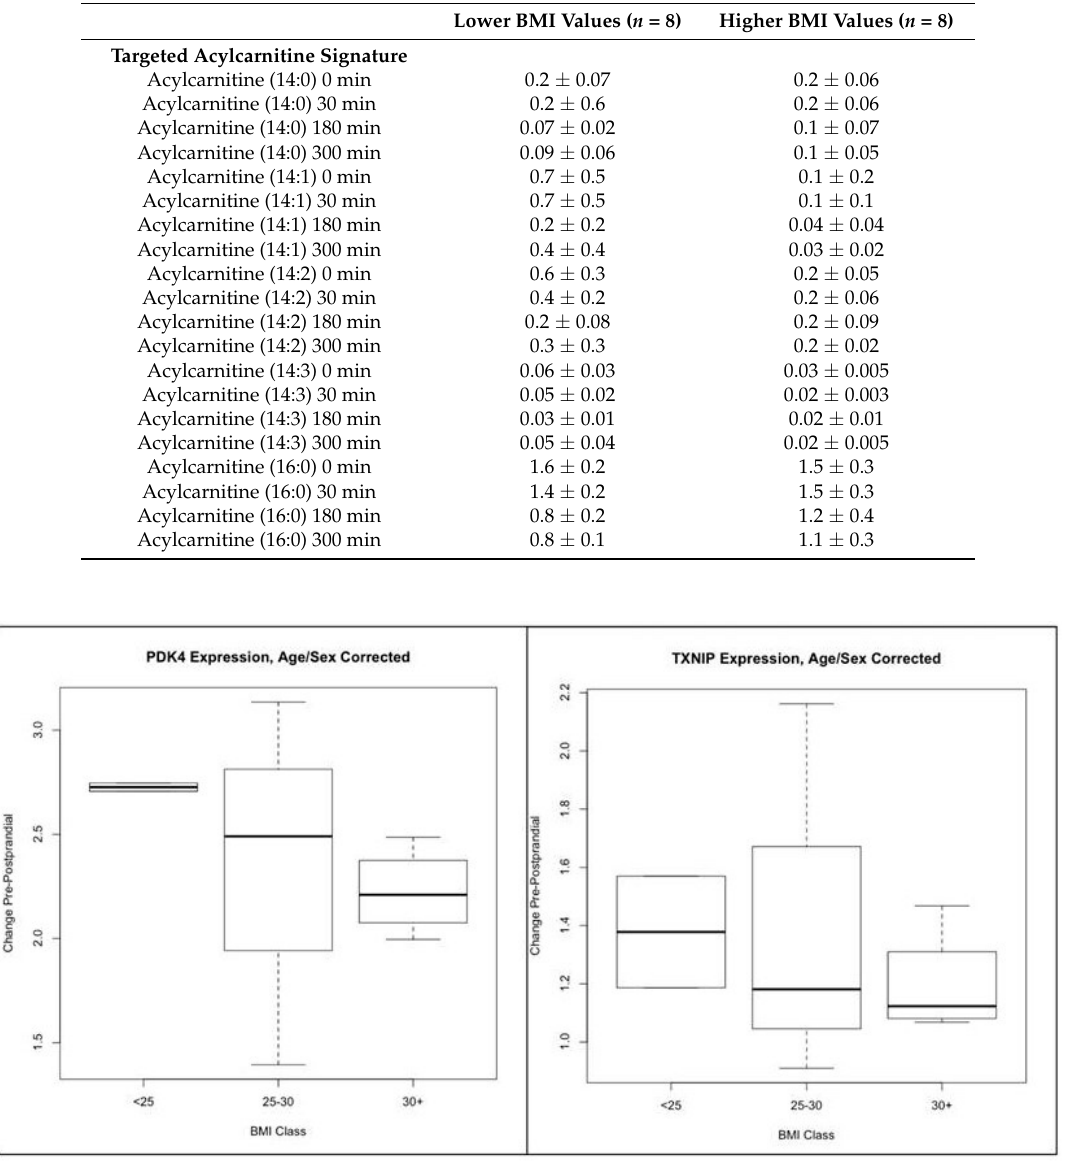
Figure 3. Transcriptomic response to meal in nine GEMM subjects. 32 transcripts in muscle (nominal p < 0.05). 15 upregulated, 7 downregulated. Include PDK4 and TXNIP at p < 1 × 10 − 5 . BMI: body mass index.